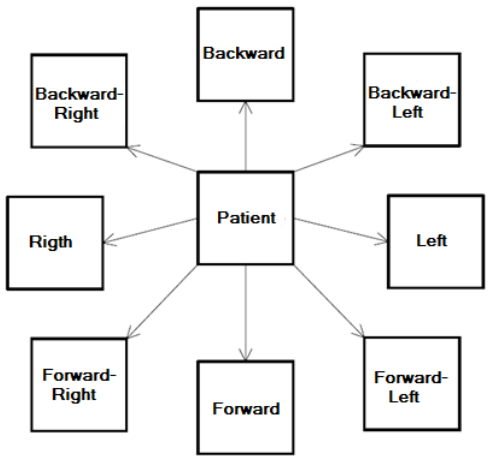
Figure 8. Target positions towards which patients have to displace their centre of gravity in the LOS assessment